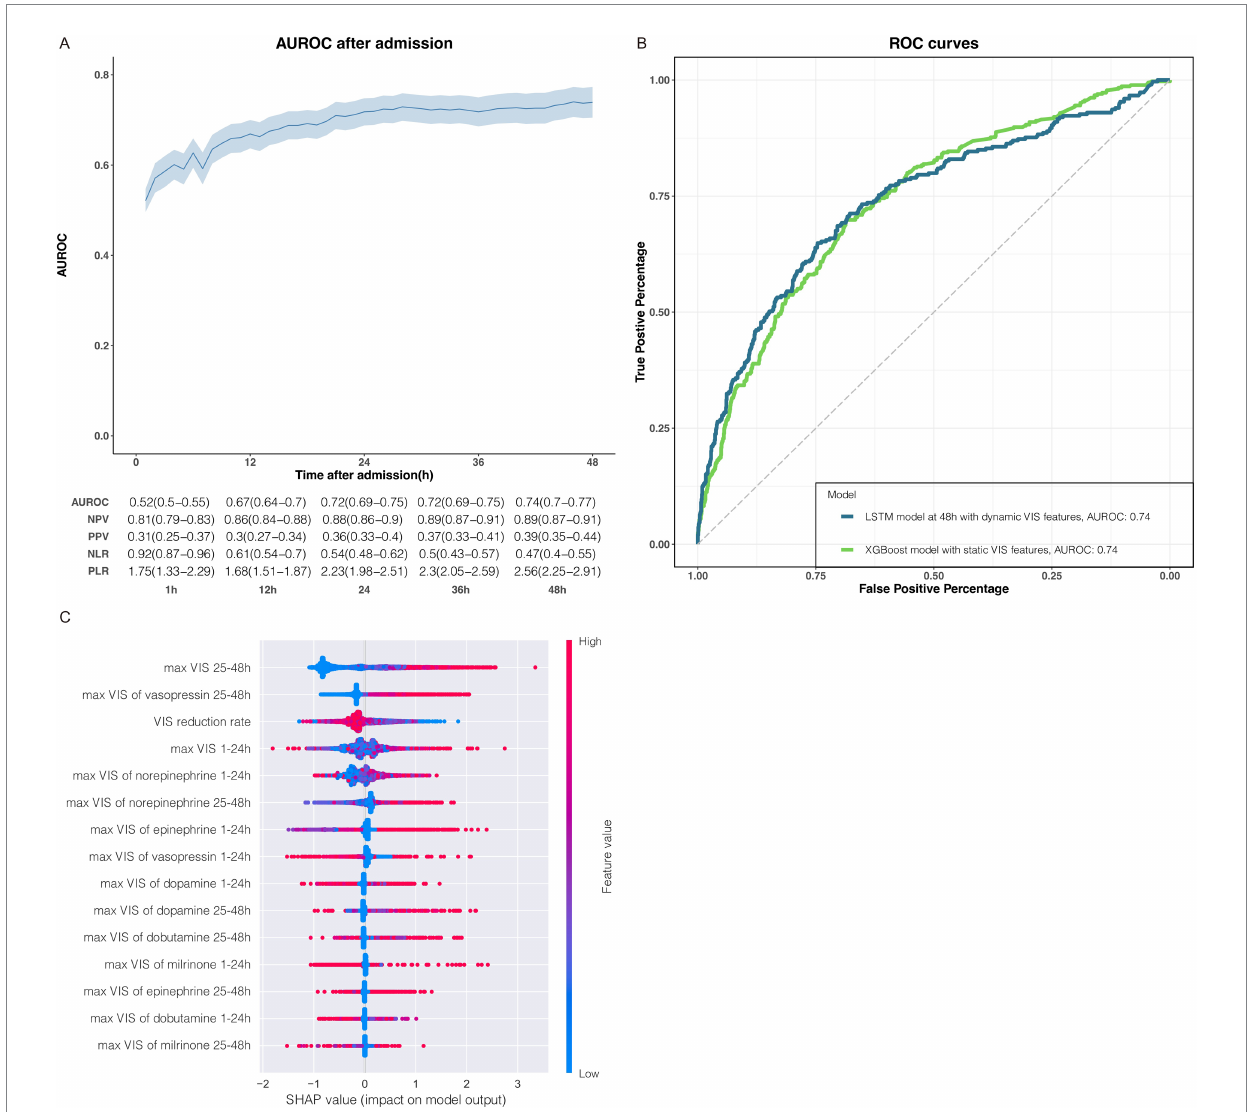
FIGURE 2 Association between VIS data and ICU mortality. (A) The performance of LSTM deep learning models were trained with dynamic VIS data during 0–1 h, 1–2 h, 1–3 h, 1–4 h, 1–5 h, 1–6 h and so on, constant increase for 1 h until 1–48 h. Model performance increasingly improved with the accumulation of the dynamic VIS data after ICU admission. The metrics for each timepoint in the graphs are displayed in the tables below with a 95% CI in parentheses. AUROC, area under the receiver operating characteristic; NPV, negative predictive value; PPV, positive predictive value; NLR, negative likelihood ratio; PLR, positive likelihood ratio. (B) Receiver operating characteristic (ROC) curves of the LSTM model and XGBoost model trained with the dynamic and the static VIS data, respectively. (C) The impact of the static VIS features on